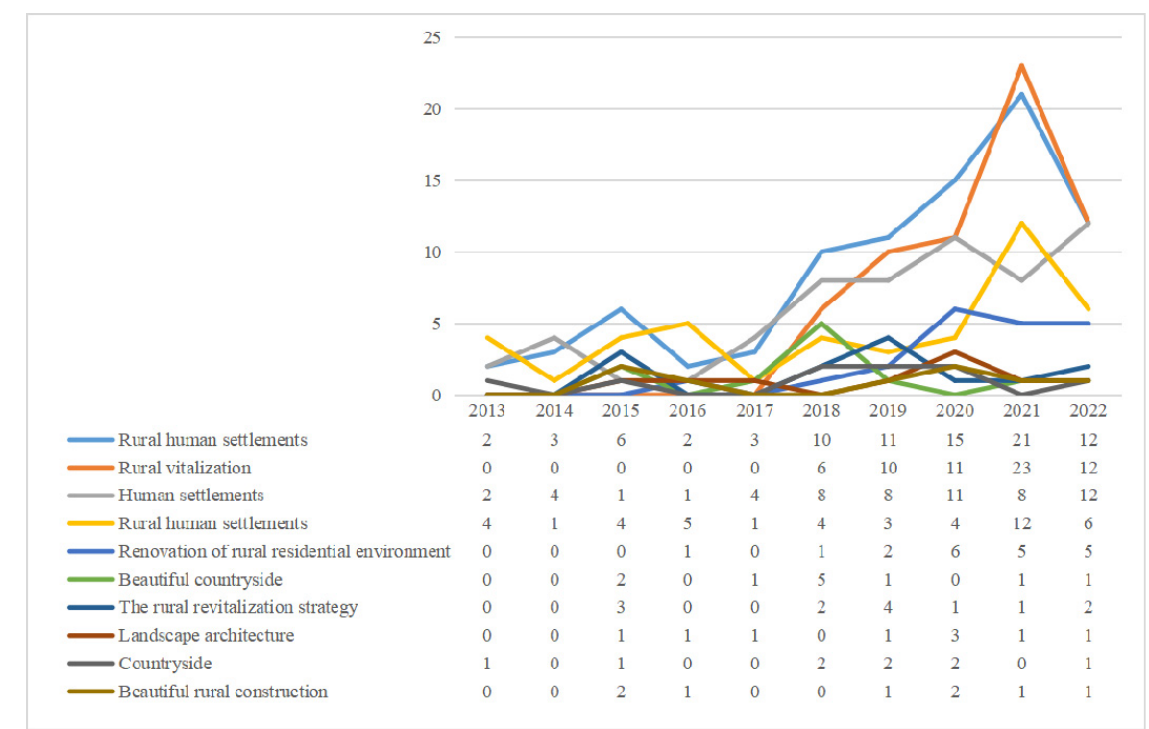
Figure 7. Keyword trend chart of rural human settlement environment research.